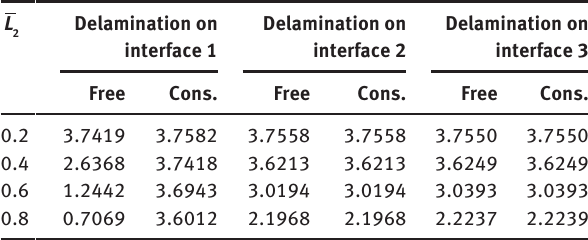
Table 9 Dimensionless fundamental frequencies of the delami- nated beams with clamped-clamped boundary conditions ( L/h = 15).